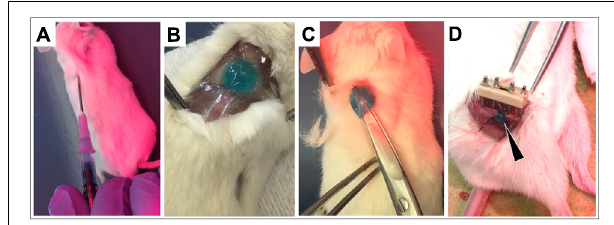
FIGURE 4 | Injection and gelation of SHP407 hydrogel in situ into murine cadavers. (A) Using an 18G needle, blue-colored SHP407 hydrogel was injected s.c. into the neck region. Physiological temperature of the organism was maintained using a heating pad and red light. (B) Solidified SHP407 gel 5 min post s.c. injection into the neck region. (C) Test of solidity by lifting the SHP407 gel up. (D) Solid SHP407 gel (black arrow) exclusively present within the osteotomy area 5 min post injection into the fracture